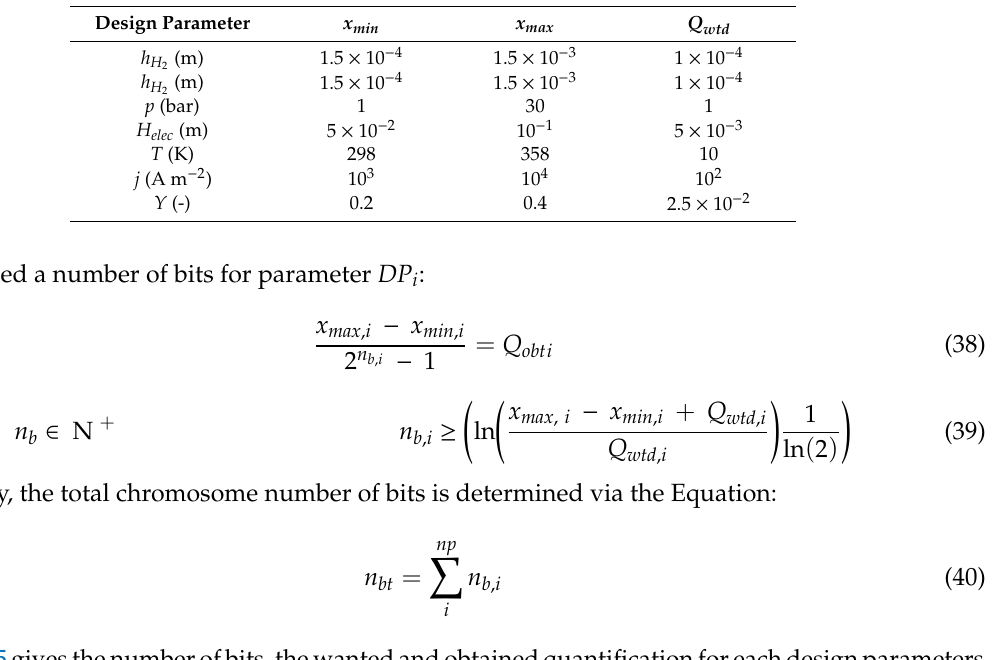
Table 4. Design parameter their intervals and their resolution.